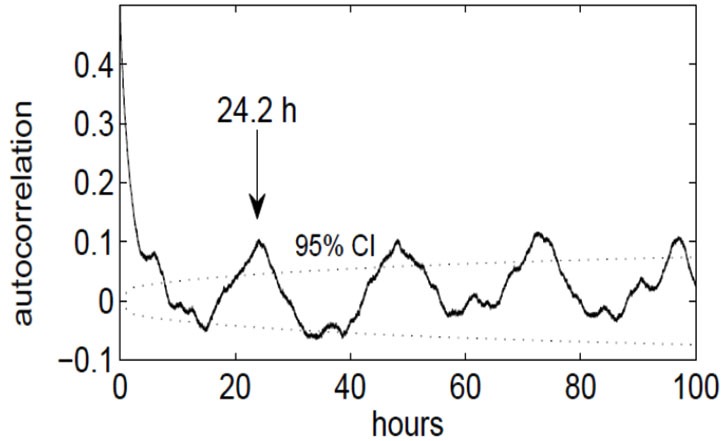
Autocorrelation function of the slow-wave on/off curve, indicating a periodicity of approximately 24 h. The dotted lines denote the upper and lower 95% confidence limit (p = 0.05), obtained by computing the effective sample size and the large-lag error by Bartlett’s formula.